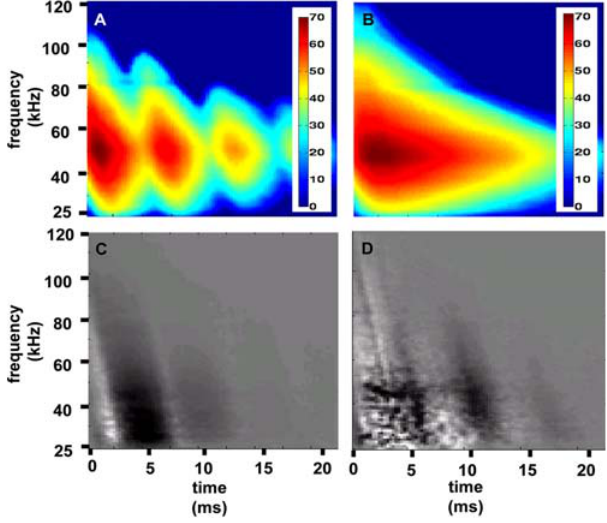
Figure 2. Decision echo analysis for the classification task: corn vs. the rest. (A) Average spectrogram of the raw data of corn. The color bars for both (A) and (B) are in dB. (B) Average spectrogram of the raw data of all the plants except corn (i.e. the rest). (C) The difference of the preprocessed spectrograms of spruce and the rest. (D) The normal vector (decision echo) to the separating hyperplane calculated for this classification task. In both (C) and (D) black represents negative values, white represents positive ones, and gray is zero.